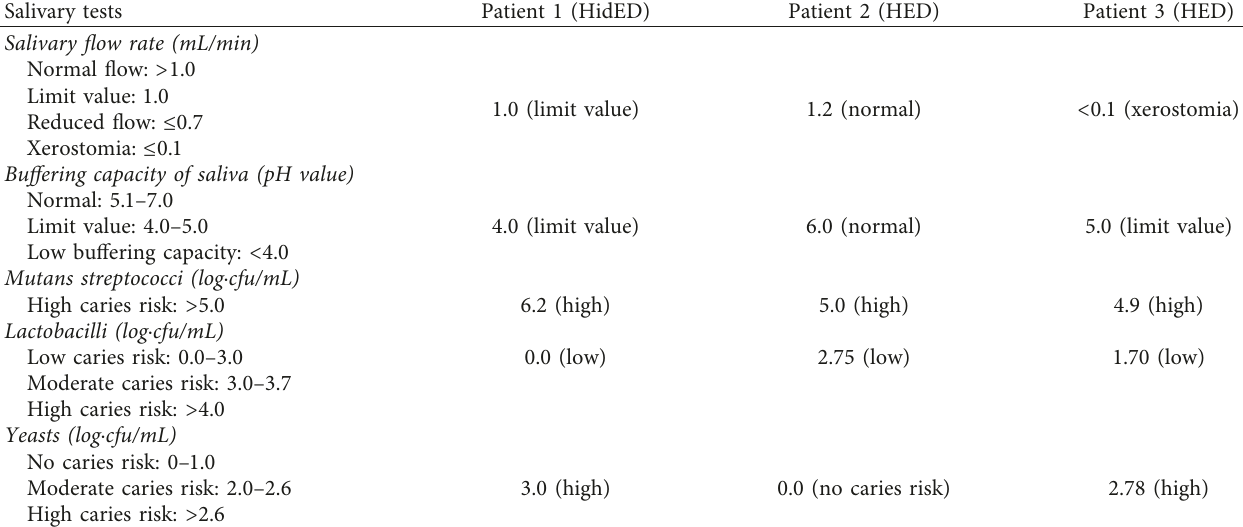
Table 1: Amount of salivary flow and buffering capacity of saliva, and counts of mutans streptococci, lactobacilli, and yeast in patients with